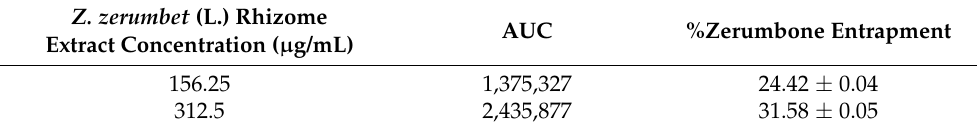
Table 2. Entrapment efficiency of the ethosomes loaded with Z. zerumbet (L.) rhizome extract. Z. zerumbet (L.) Rhizome Extract Concentration ( µ